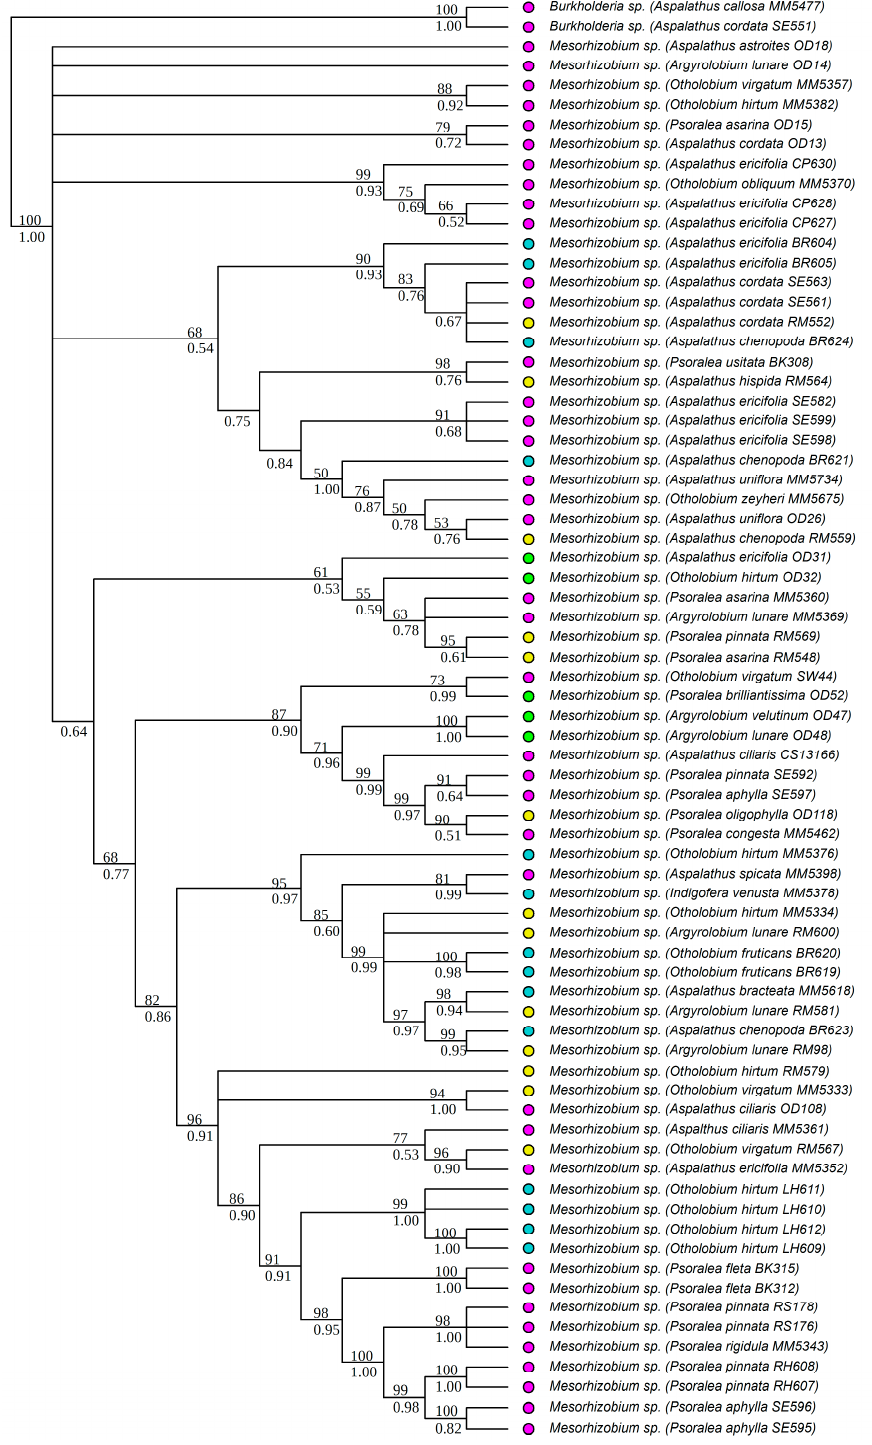
Figure 2. Phylogenetic relationships of Mesorhizobium strains based on 16S rRNA and recA data. Names of the legume hosts and rhizobial strain numbers are in parentheses. Strain numbers with the prefixes OD- and MM- are from the study by Lemaire and co-workers [21]. The rest were newly generated in this study. ML bootstrap (%) and BI posterior probabilities are shown above and below nodes, respectively. Colored circles indicate the soil types of the sites where the legumes and their symbionts were collected, blue: granite; green: limestone; pink: sandstone, yellow: shale.